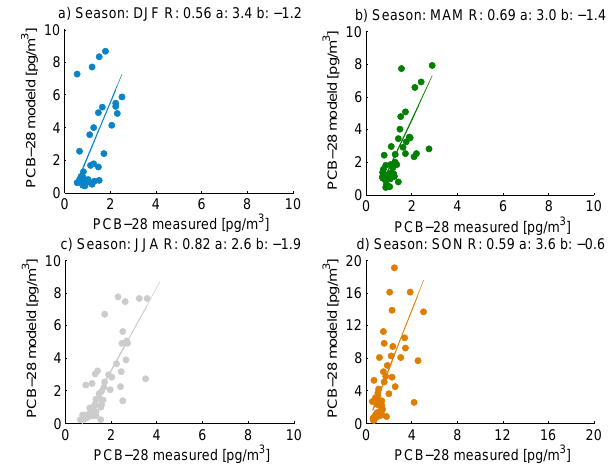
Fig. 8. Correlation between modeled and observed PCB-28 for the four seasons. On top of each panel, correlation coefficient R , slope a and intercept b are